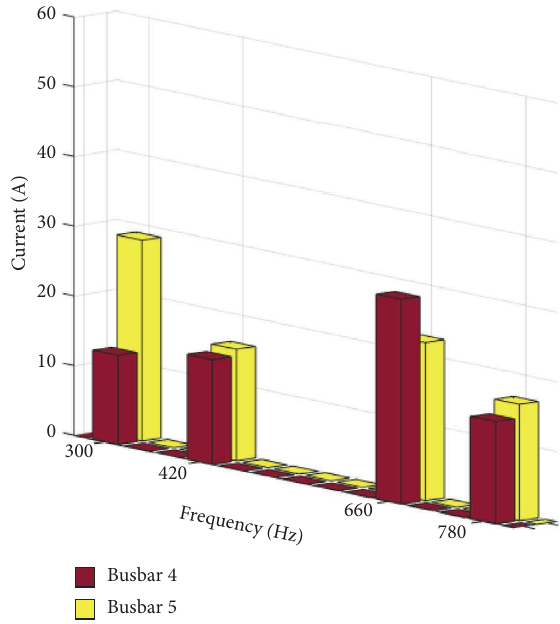
Figure 8: Case 3-Harmonic Current Spectrum in busbars 4 and